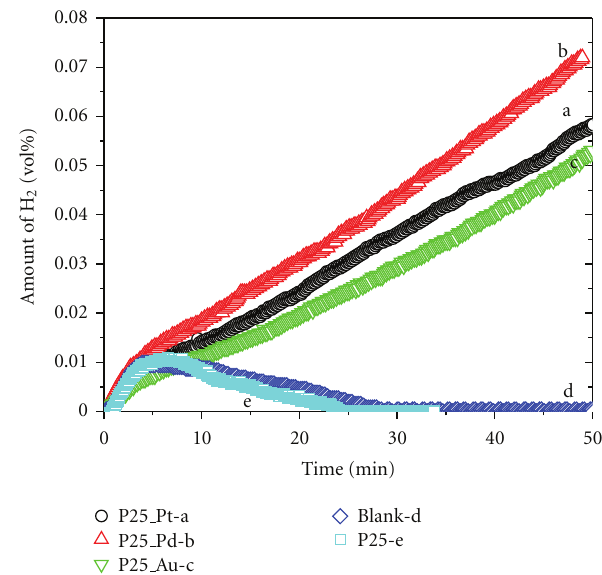
Figure 3: H 2 evolution on Pd, Pt, and Au deposited Degussa P25, pure Degussa P25, and pure water without catalyst